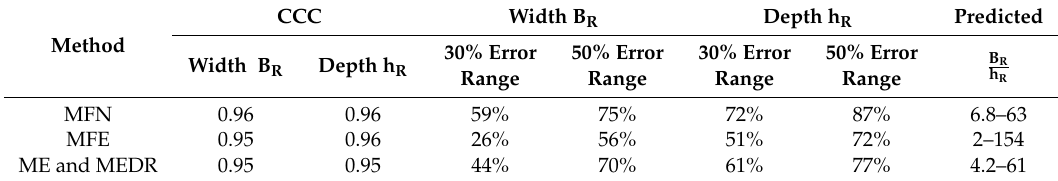
Table 2. Statistics computed for MFE, MFN, and ‘ME and MEDR’ based on sand bed data.